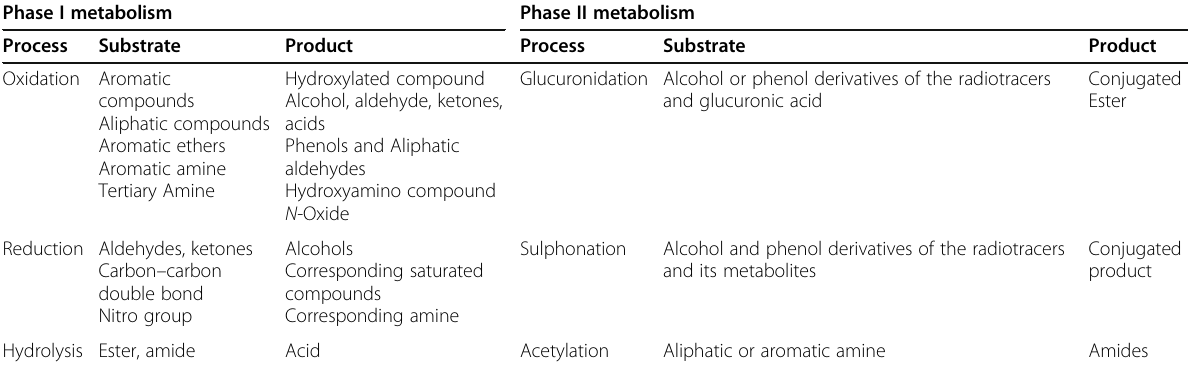
Table 1 Phase I and phase II metabolism of the